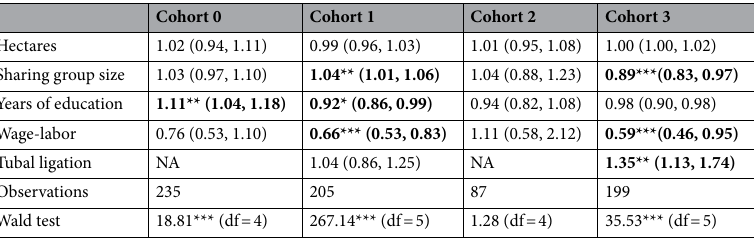
Table 3. Hazard ratios (95% CI). Bold indicates statistically significant effects. * p < 0.05 ** p < 0.01 *** p <